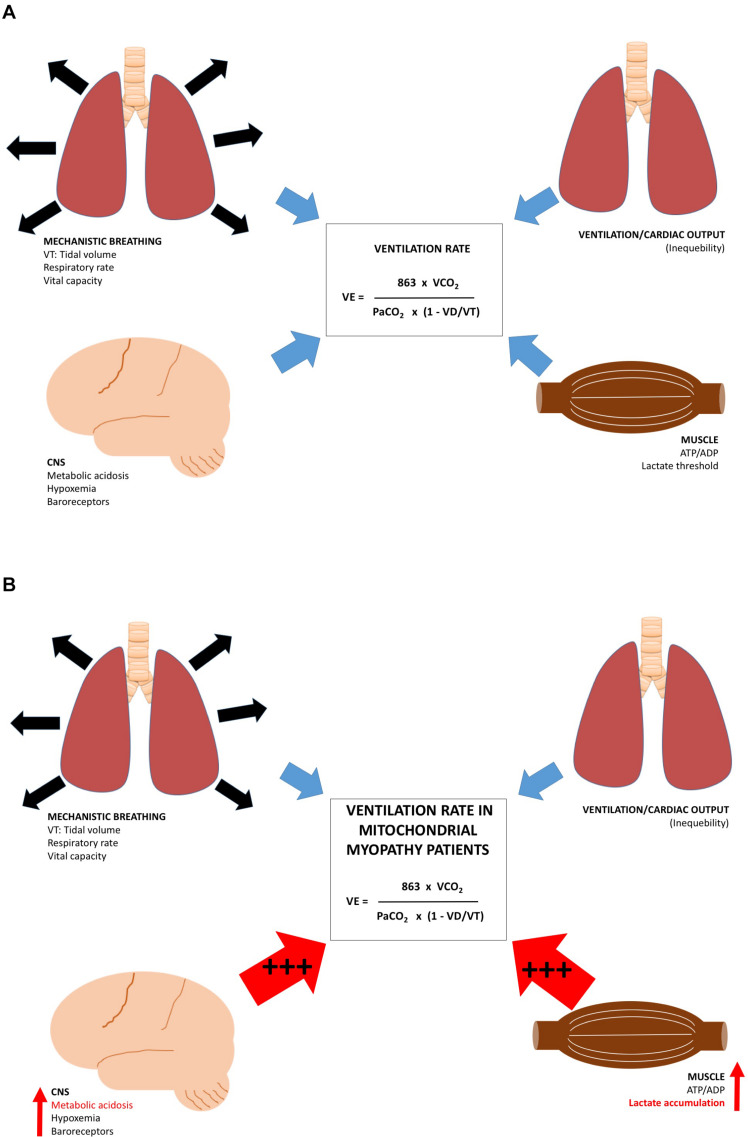
Regulating factors for ventilation rate at rest and during exercise. Different regulating factors for rate of ventilation. (1) factors responsible for lung function, (2) Central nervous system, (3) relationship between cardiac output, and oxygen uptake in the lungs, and (4) ATP/ADP, lactate and pH in skeletal muscle in (A) healthy subjects and (B) patients with mtDNA mutation. During exercise, patients with mtDNA mutation have an excessive metabolic acidosis increasing the CNS-mediated drive on ventilation rate (+++), the ATP/ADP ratio (+++), pH drop, and lactate concentration accumulate (+++), which result in increased skeletal muscle drive on ventilation rate.